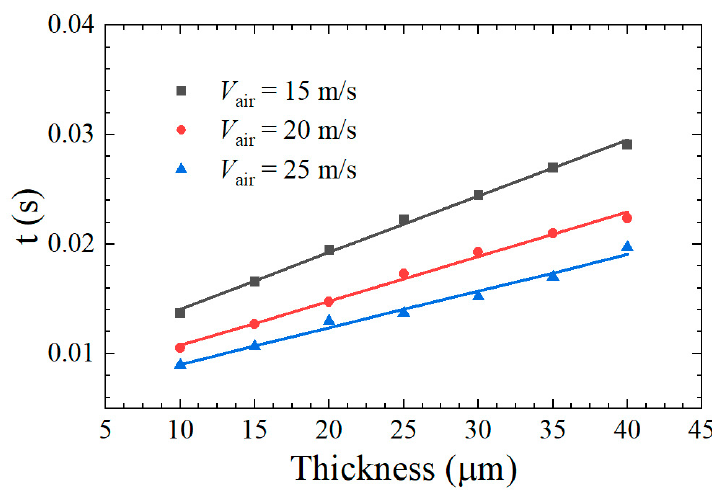
Figure 13. Variation in drying time with water-based ink thickness.